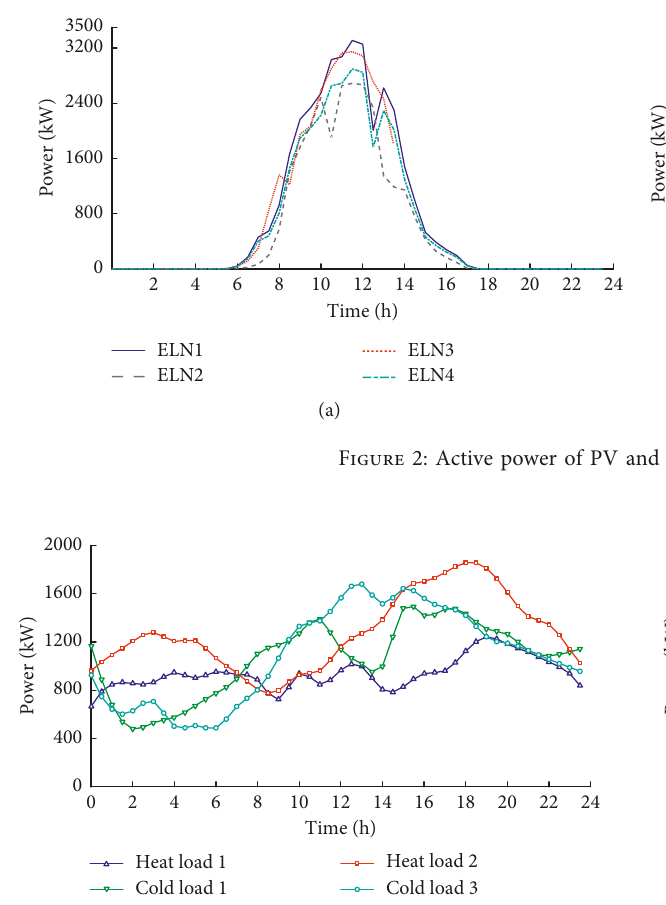
Figure 3: The cooling and heating loads of ELNs.